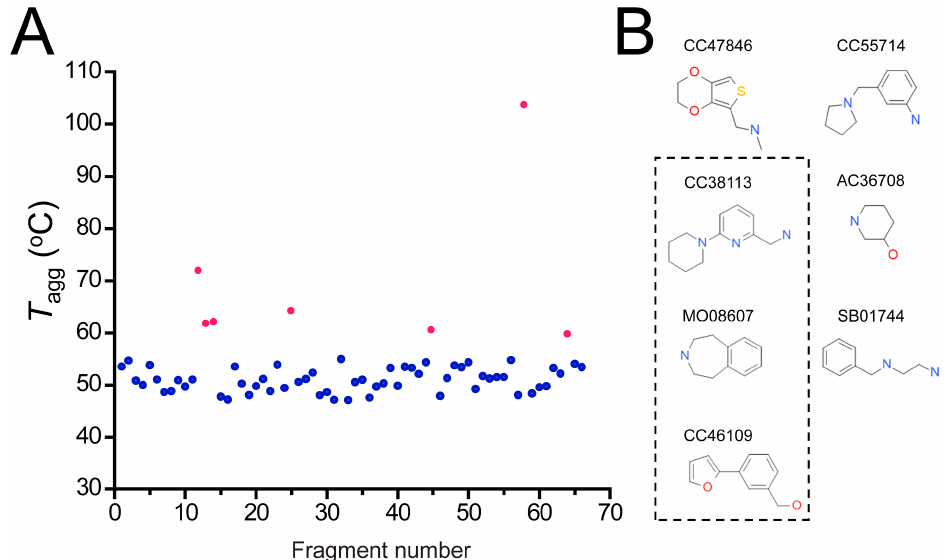
Figure 6. T agg of hAQP1 in the presence of hit fragments. ( A ) scatterplot of T agg values of hAQP1 in the presence of each of the 66 top fragment binders identified from SPR assay, screened here at 1 mM by differential static light scattering. Each point is an average of three independent measurements. Fragments which stabilized hAQP1 by 1 °C or more are indicated as red dots, whereas the rest are shown in blue; ( B ) structures of the fragments identified in ( A ). Compounds also identified as the top 10 binders by SPR appear inside a box.